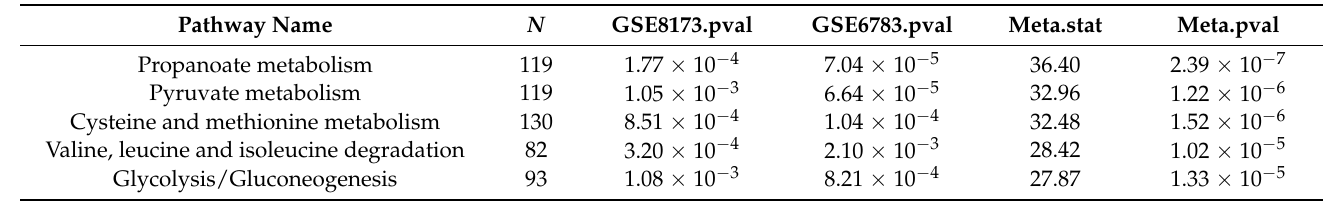
Figure 6. Functional enrichment analysis of differentially coexpressed genes with gene ontology (GO) biological process (BP) terms. The bar indicates -log (enrichment p -values). In the figure, top 10 most significant GO BP terms are listed. See Supplementary Table S6 for the total results. Table 3. Result of global test with KEGG pathways.